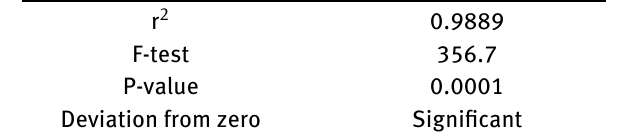
Figure 2: Dependence of postal item on households with Internet